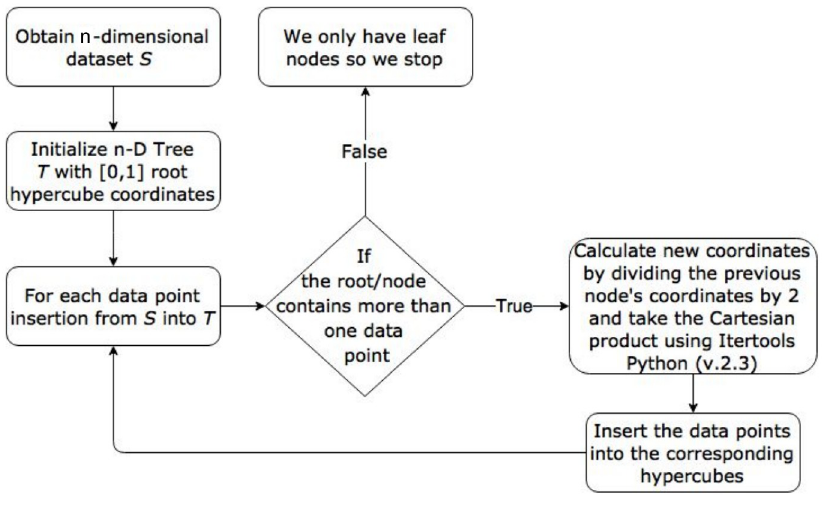
Fig 1. n-D Tree data insertion algorithm.